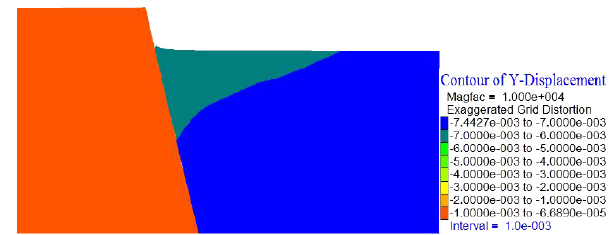
Figure 5. The annual settlement in scheme 2 (scaled up to 10000 times of the original).